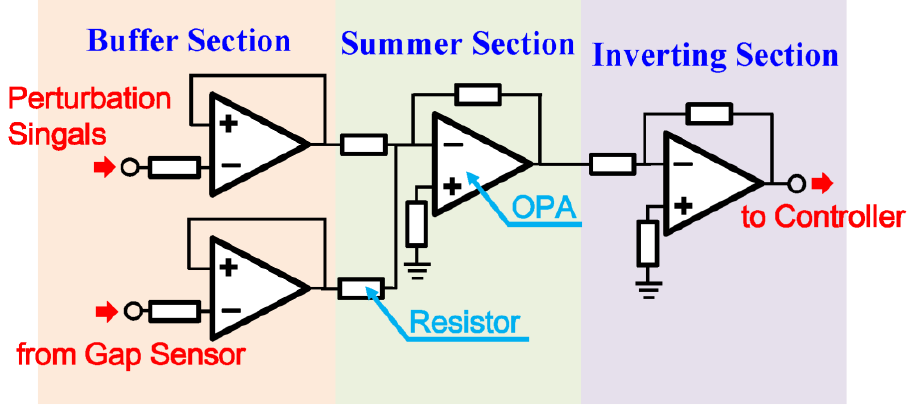
Figure 10. Layout of summer module.